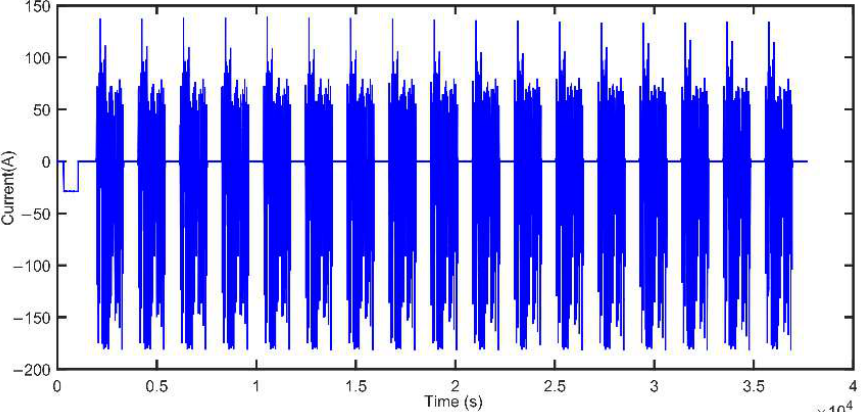
Figure 7. Current of dynamic condition test 1 experiment.